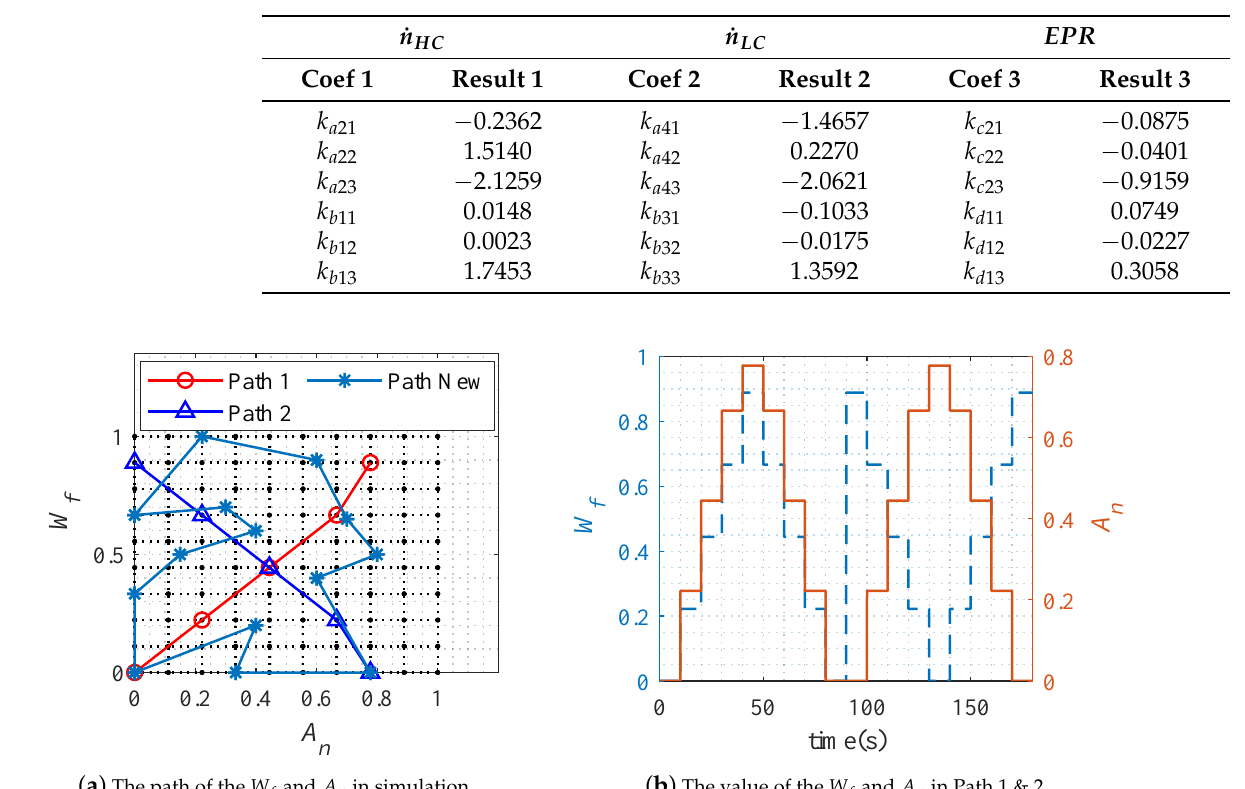
Table 4. The coefficients of the EME ( α = [ n HC , A n ]) model.